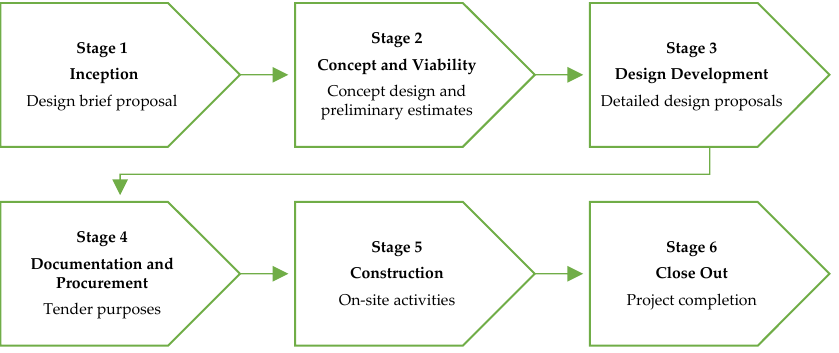
Figure 1. Flow chart of overall design building process [2].